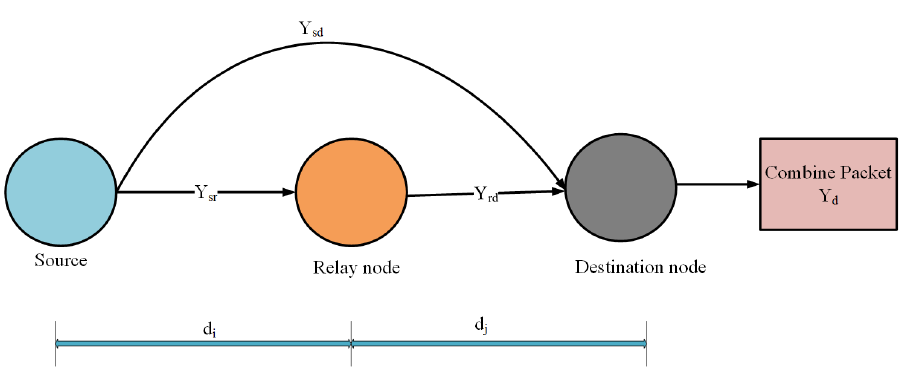
Figure 8. MRC Model.